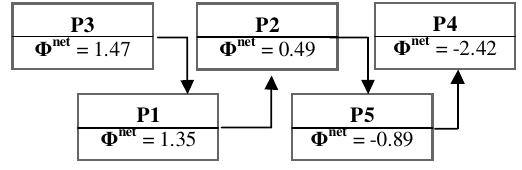
Figure 7. PROMETHEE II results for the alternative press machines